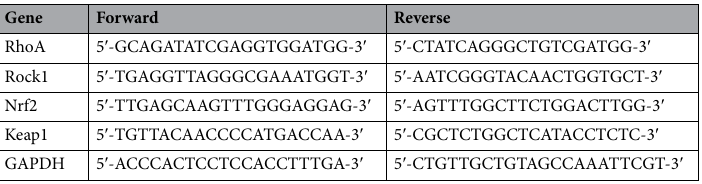
Table 1. Oligonucleotides for